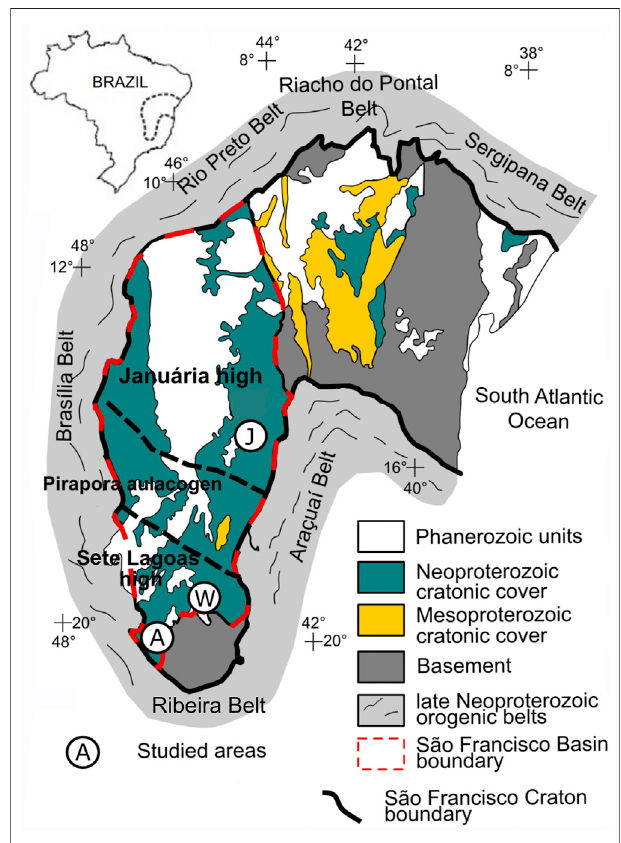
FIGURE 2 | The São Francisco Craton geological map and the São Francisco Basin. Studied sections: A, Arcos; W, Well 1; J, Janu (cid:1) aria. Modi fi ed after Caetano-Filho et al.